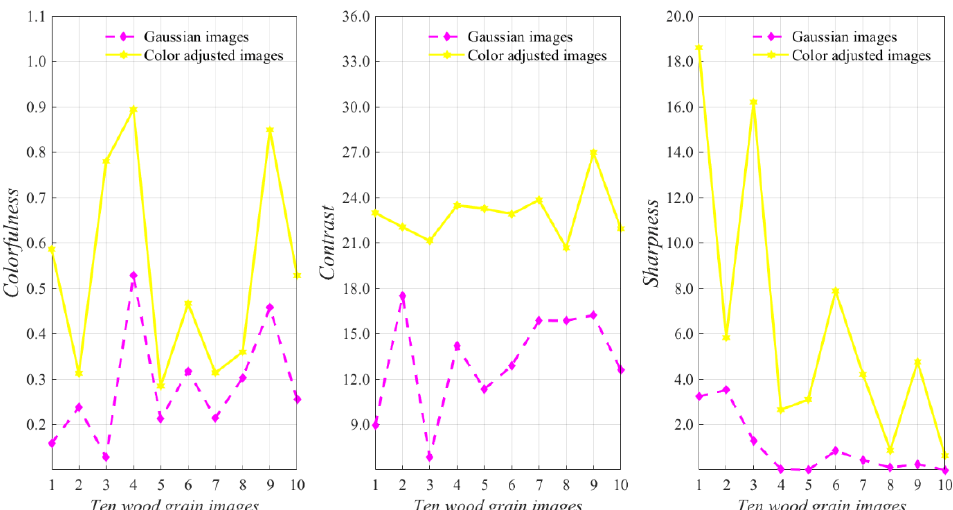
Figure 7. Changing trends of objective evaluation values of colorfulness, contrast, and sharpness on the ten Gaussian images before and after the adaptive color adjustment.